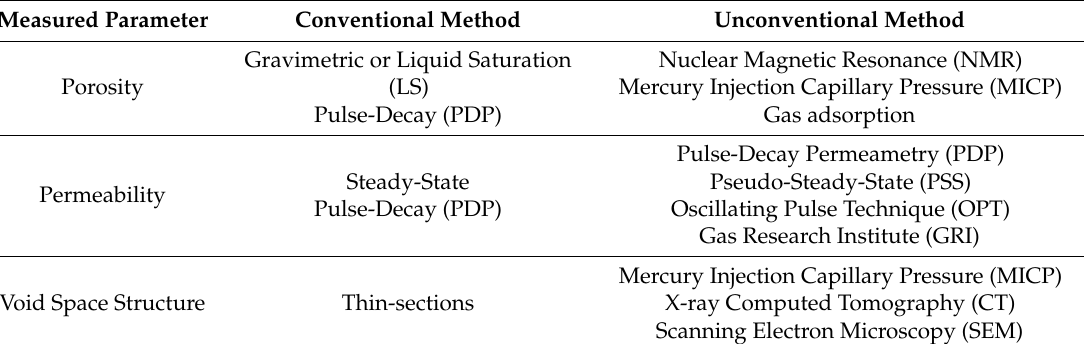
Table 1. Methods applied for reservoir properties’ laboratory